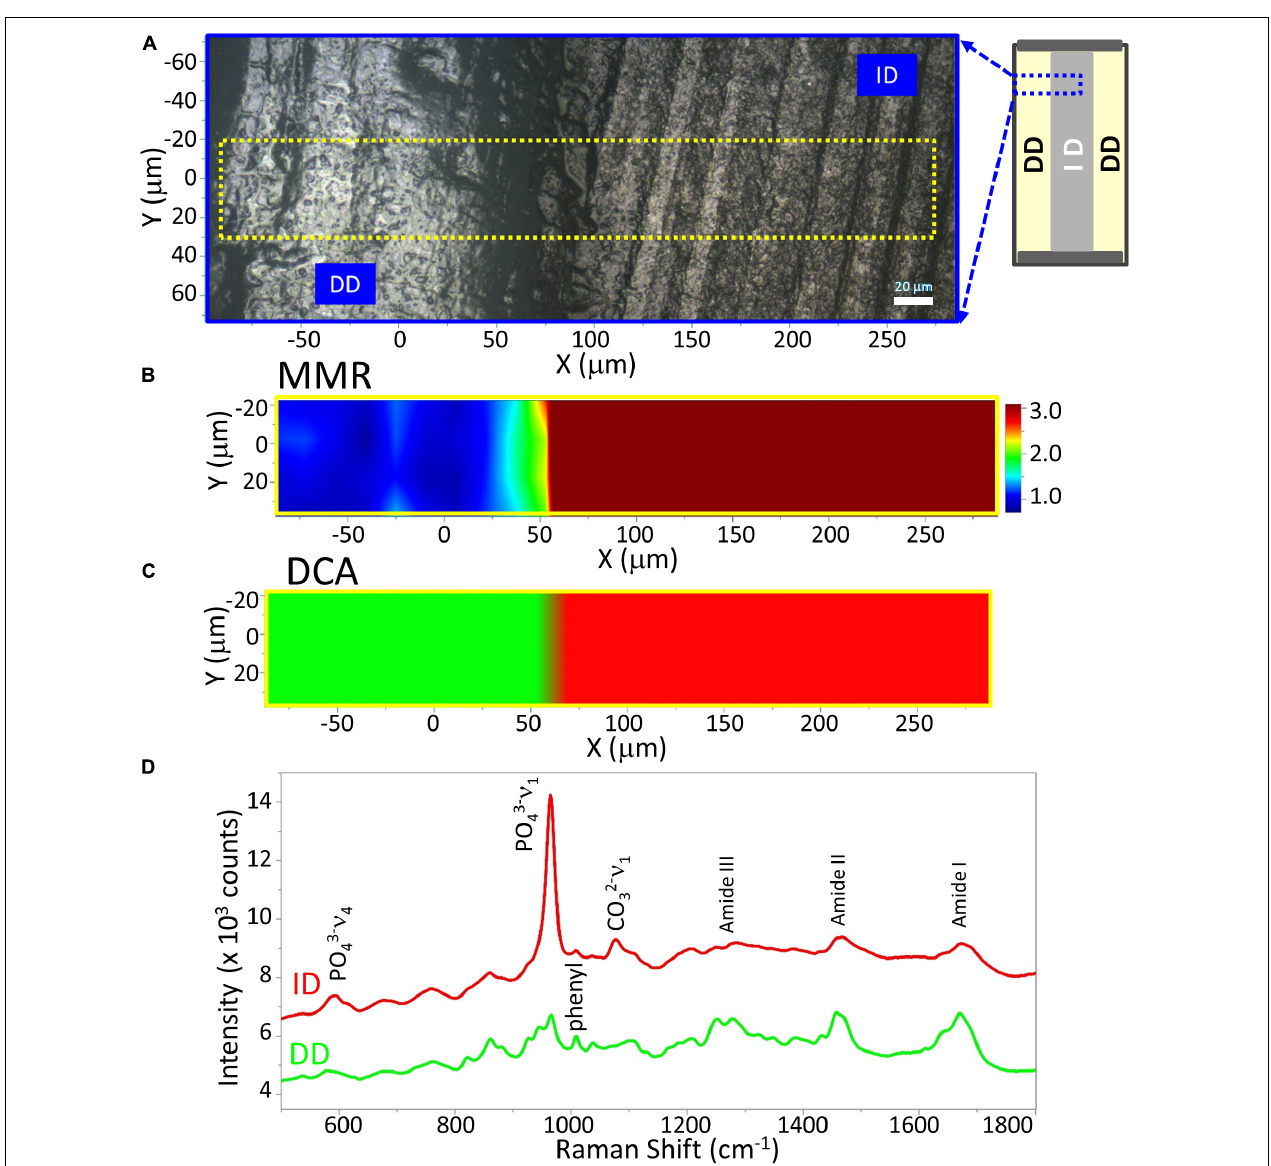
FIGURE 3 | Raman analysis of a representative demineralized dentin disc (control). (A) Light micrograph marked with a X-Y scan area. Scan bar is 20 µ m. (B) µ -Raman mineral map (MMR) of the X-Y scan area. Blue represents the lowest ratio, while red represents the highest. (C) K-means clustering map (DCA) of the Raman profile of the same scan area. Two distinguished classes are identified, e.g., intact dentin (ID) and demineralized dentin (DD) region. (D) µ -Raman spectra of two classes, corresponding to ID and DD